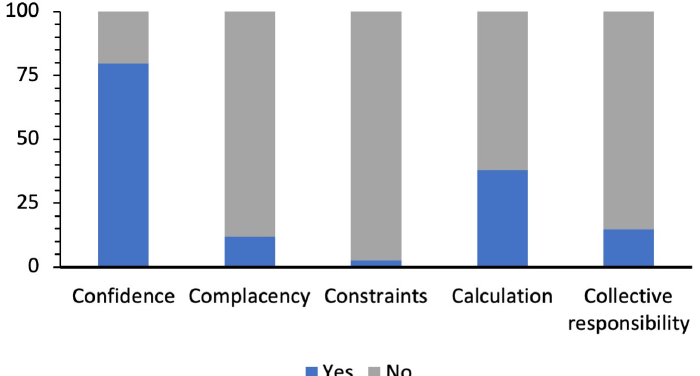
Figure 1. Overall results for Coronavirus disease 2019 psychological antecedents.